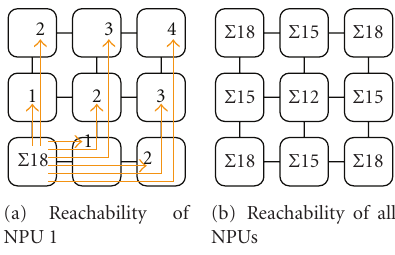
Figure 4: Reachability